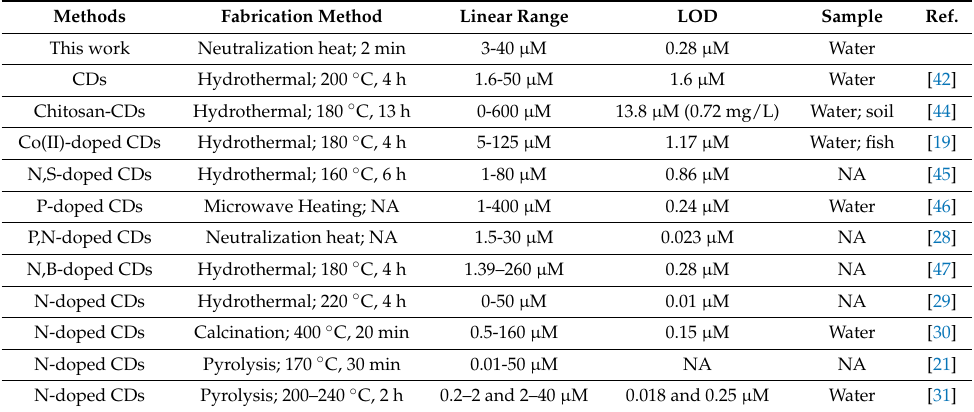
Table 2. Comparison of CDs-based fluorescence methods for the detection of